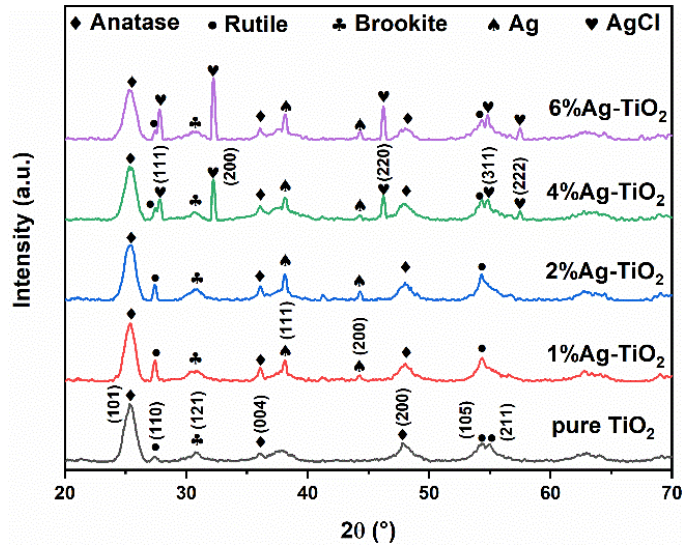
Figure 1. XRD patterns of pure TiO 2 and Ag-TiO 2 .